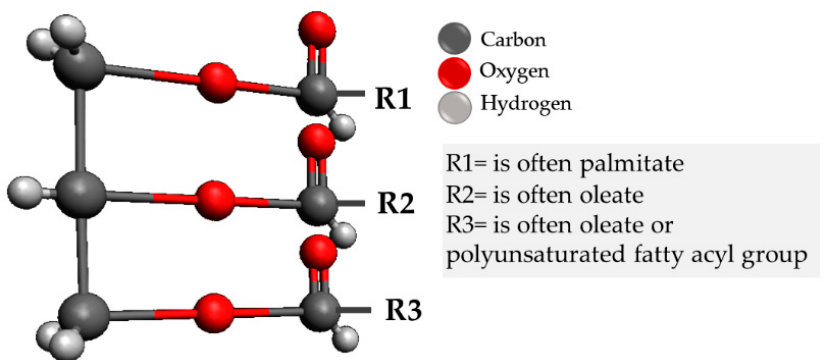
Figure 2. Schematic representation of the triacylglycerol molecule structure. Fatty acid is represented by R1 to R3.